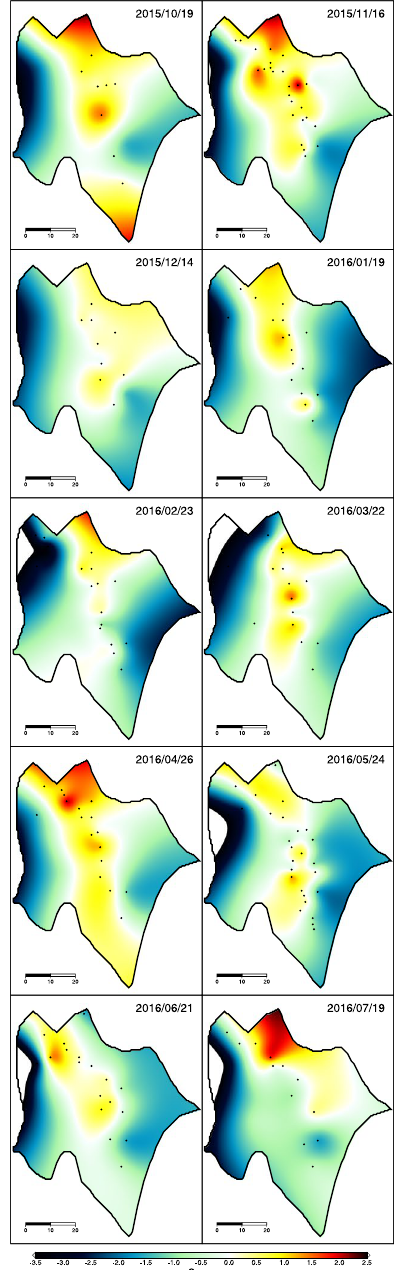
Fig. 7 The colored contour plot of F2 scores on 10 investigations. Black dots denote sampled mud pools. The unit of the scale bar is meter. High score mud pools (red) dominate the north side of the field and extend to the shield axis (central) on several sampling dates. Low score mud pools (dark blue) dominate flanks of the mud shield. Mud pools along the shield axis show great temporal and spatial variations while flank pools are in relatively stable condition. The end member sites are used as constrain points (i.e. D4, E1, F1, and